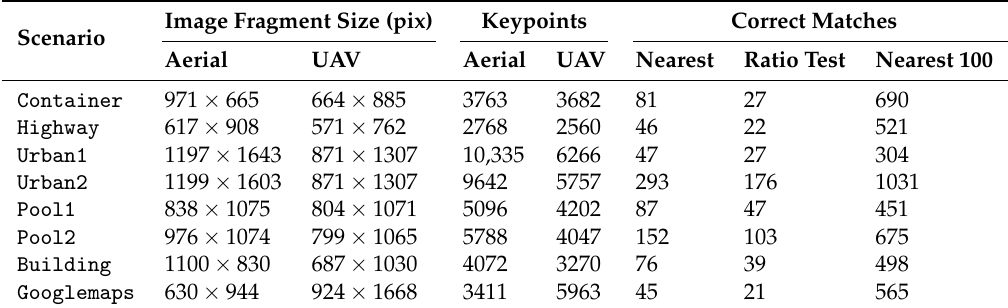
Table 3. Analysis of standard SIFT matching on the proposed datasets in Figure 2. Matching was performed on downsampled UAV images and cropped aerial images on the same image content of the UAV image. Keypoint detection was limited to 3 octaves and 5 levels, and the ratio test threshold was set to 0.75. Results show the number of feature points detected by the SIFT-detector, correct matches considering only the first nearest neighbor, after applying the ratio test and possible matches according to 100 nearest neighbors.